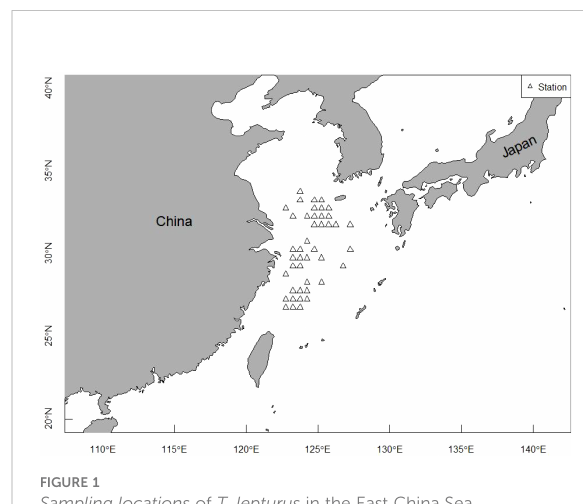
FIGURE 1 Sampling locations of T. lepturus in the East China Sea.